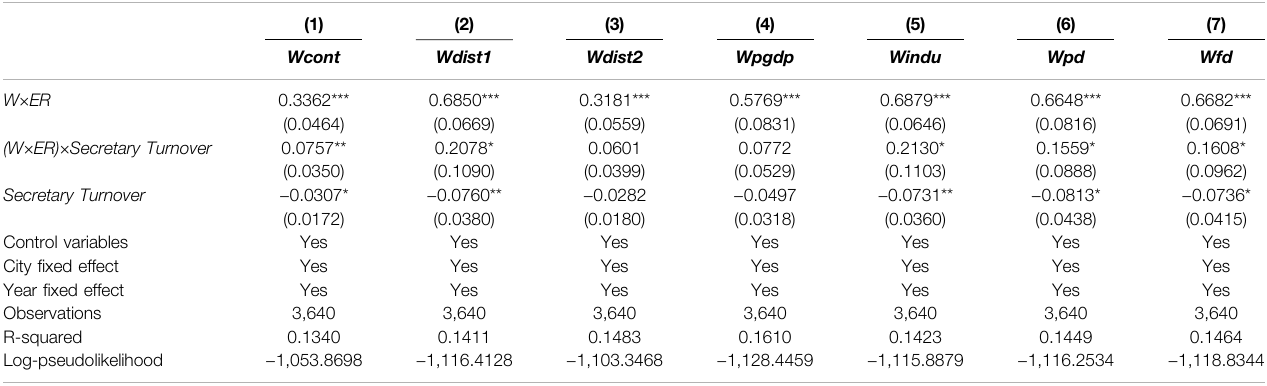
TABLE 11 | Estimates for secretary turnover and strategic interactions in environmental regulation.